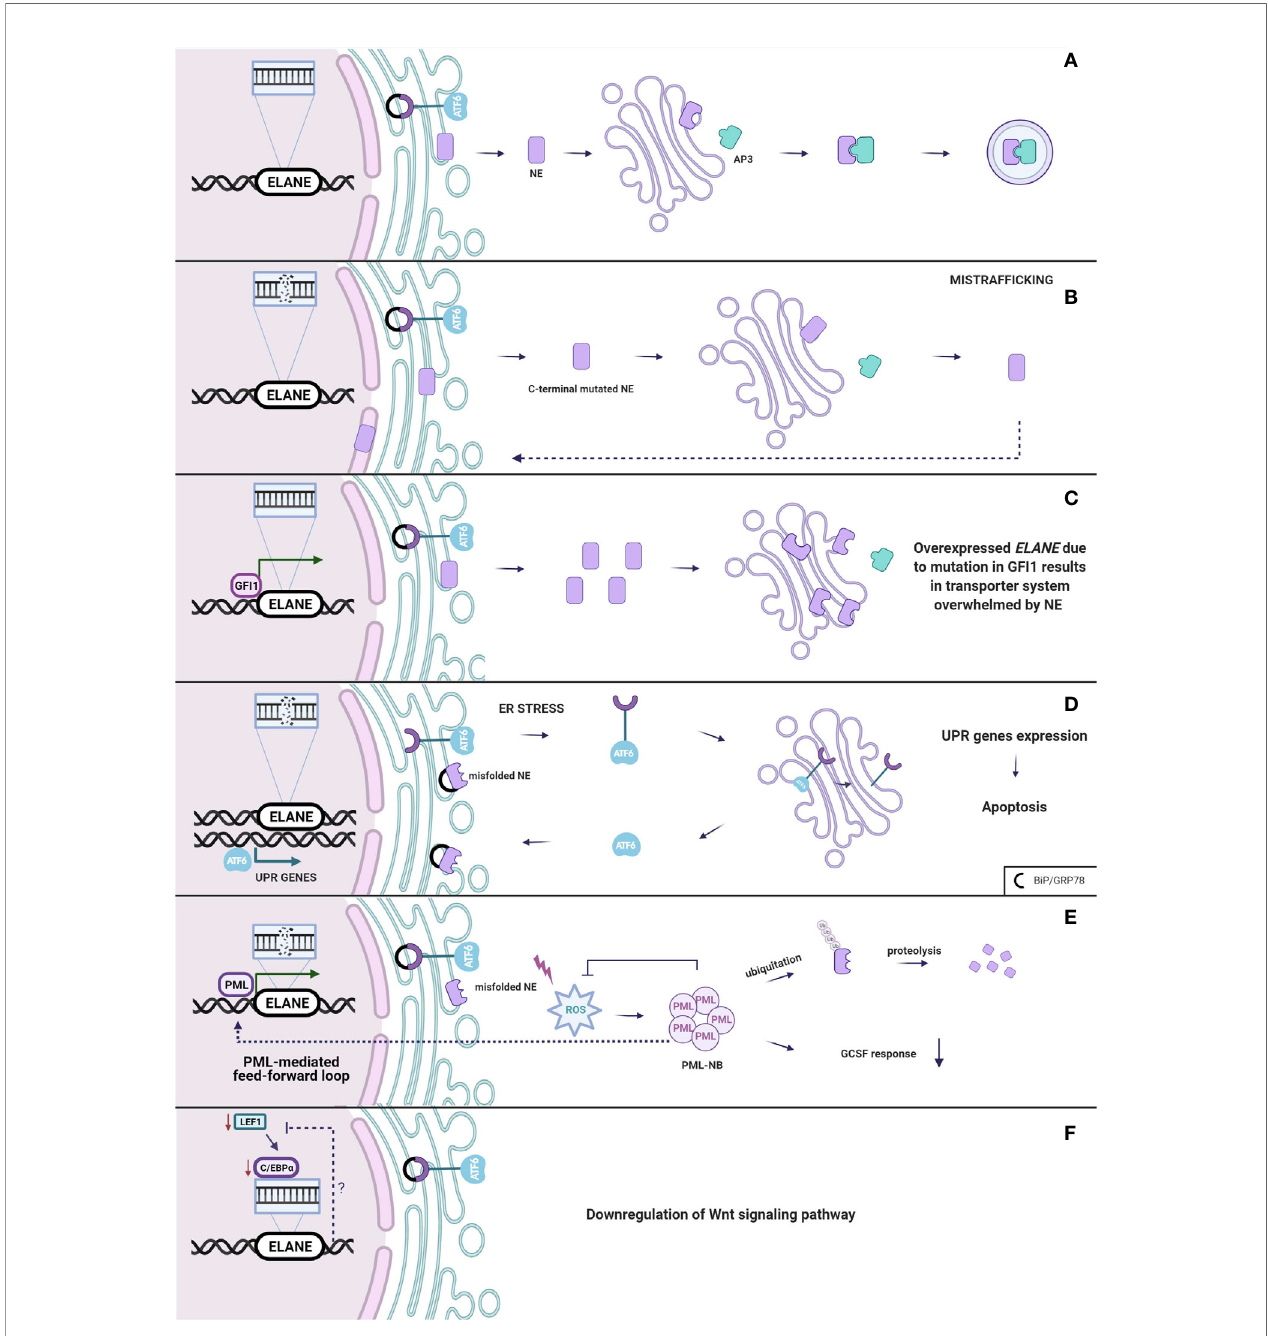
FIGURE 2 | (A) Neutrophil elastase is traf fi cked from Golgi to the granules. (B) Mistraf fi cking. Mutation in ELANE results in intact C-terminal of NE disrupting an interaction between AP3 which mislocates it to the cytoplasm, plasma and nuclear membrane. (C) Overexpressed ELANE due to mutation in GFI1 results in the transporter system overwhelmed by NE. (D) Unfolded protein response. Misfolded NE accumulation in ER leads to the ER stress and molecular chaperones upregulation and a subsequent induction of the UPR. (E) PML-mediated feed-forward loop. PML binds to ELANE promoter inducing misfolded NE expression thus increases ROS production and PML-NBs formation. (F) Either Lef-1 downregulates ELANE downstream or the Wnt pathway is downregulated through a negative feedback loop from mutated ELANE . Created with